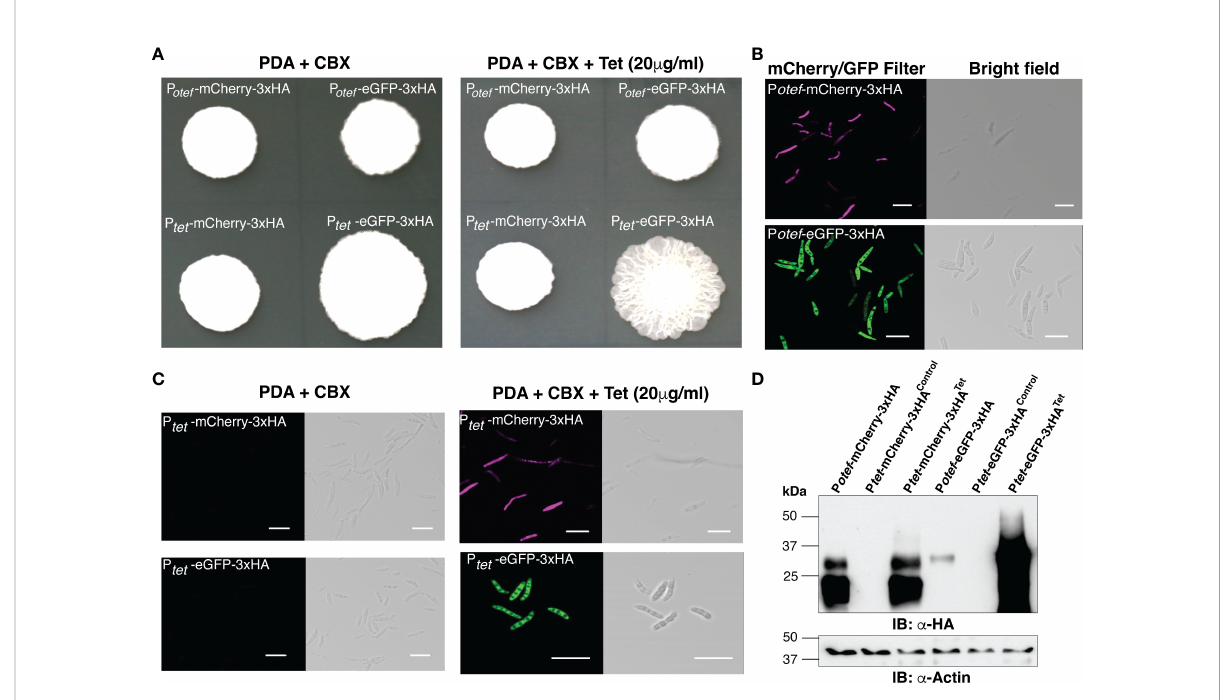
FIGURE 2 Induction of mCherry and eGFP with TetON system. (A) Growth of indicated U. maydis strains on Potato Dextrose agar (PDA)+CBX ± Tet (20 m g/ml). Plate photographs were taken on the 4th day after spotting. (B) Confocal images of cells from SG200:P P otef -eGFP-3xHA after 4 days of growth on PDA plates (Scale bar= 20 m m). (C) Confocal images of cells from SG200:P tet -mCherry-3xHA and SG200:P tet -eGFP-3xHA after 4 days of growth on PDA+CBX ± Tet (20 m g/ml) plates (Scale bar= 20 m m). (D) Immunoblot with a -HA and a -Actin antibodies (loading control) on total protein extracts from indicated strains grown on PDA+CBX ± Tet (20 m g/ml)